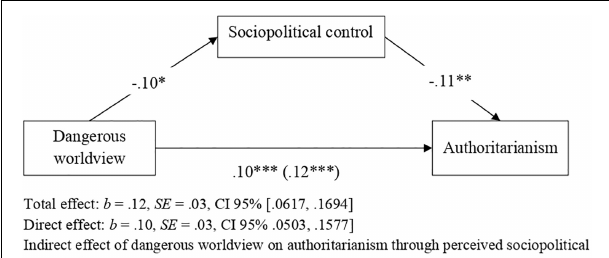
FIGURE 4 | Direct and indirect effect of dangerous worldview on authoritarianism through perceived sociopolitical control. Unstandardized coefficients presented. * p < 0.05, ** p < 0.01, *** p <